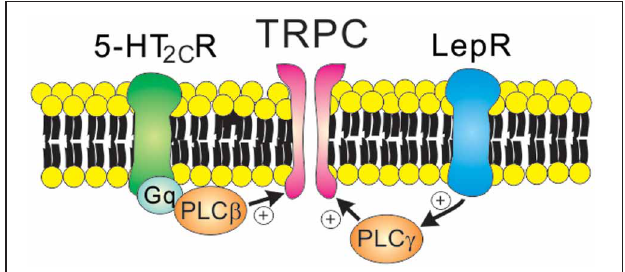
FIGURE 3 | Receptor-mediated regulation of GIRK channels. GIRK channels are activated by the direct binding of G βγ subunits in a membrane-delimited manner. Typically, G βγ subunits which open GIRK channels originate from the Gi/o protein-coupled receptors such as Y receptors, GABA B receptors, and κ 2 opioid receptors.